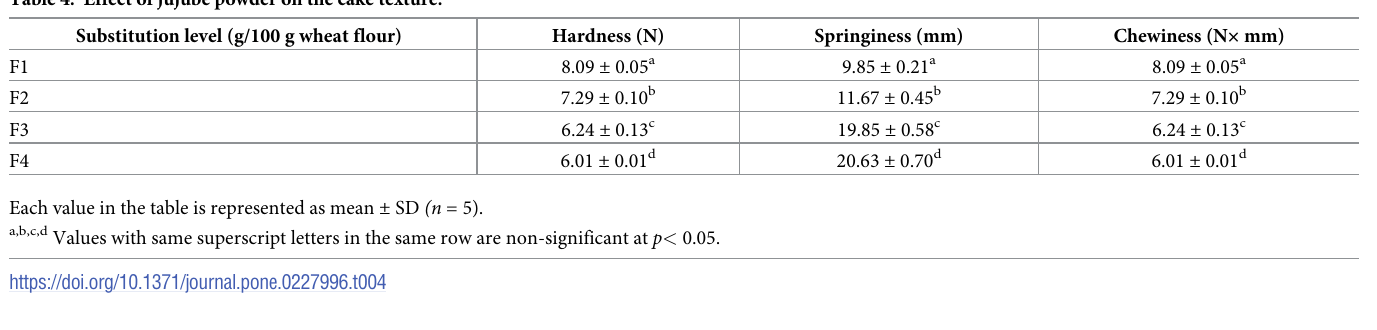
Table 4. Effect of jujube powder on the cake texture.